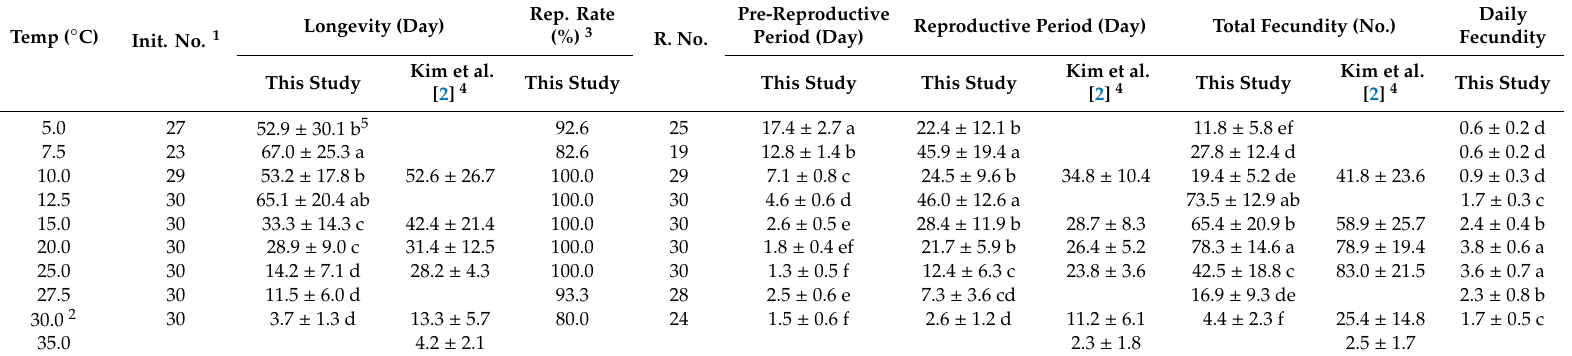
Table 2. Developmental duration (days) and fecundity of A. solani adults on soybean at constant temperatures. Temp ( ◦ C) Init. No.